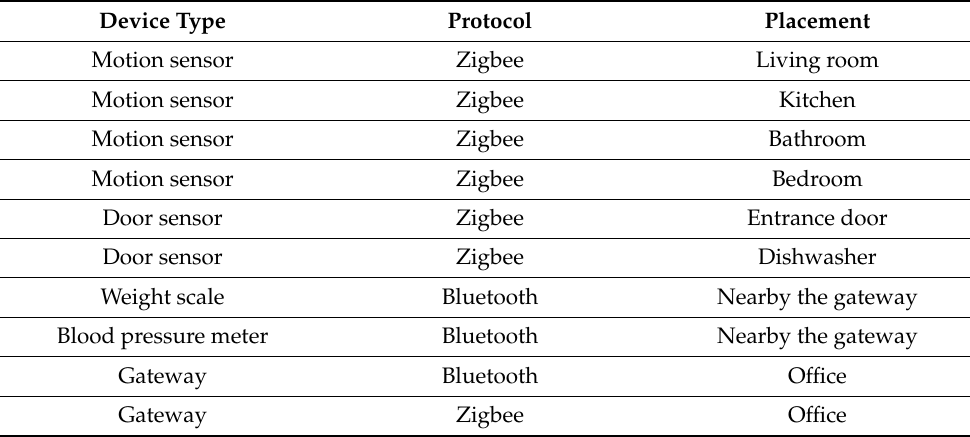
Table 2. Device deployment places [32].